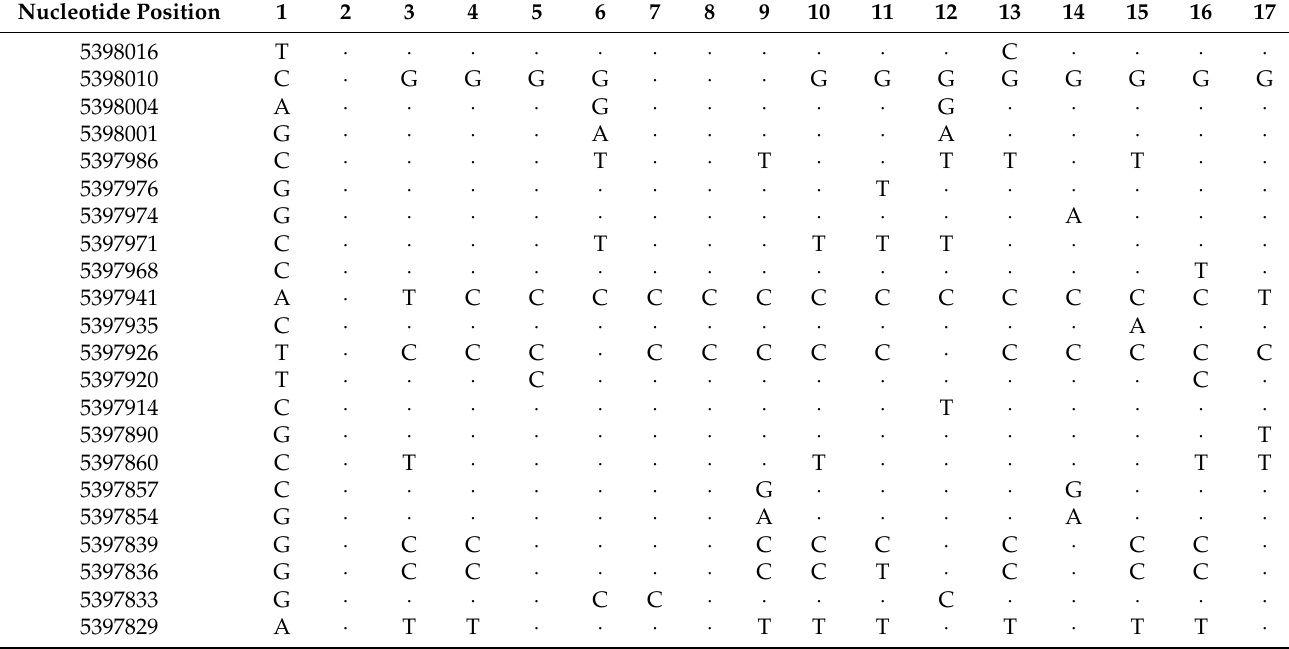
Table 3. Mutations in the hsp65 gene sequences of the portion considered in the study found in the NCBI Nucleotide database. Reference strains indicated as type strain in Bergey’s manual [54] were considered. Nucleotide positions refer to those obtained by aligning type strains sequences with the complete genome of M. fortuitum subsp. fortuitum strain ATCC 6841 (Sequence ID: CP014258.1). The dot ( · ) indicates identical base compared to M. fortuitum subsp. fortuitum strain ATCC 6841 taken as reference